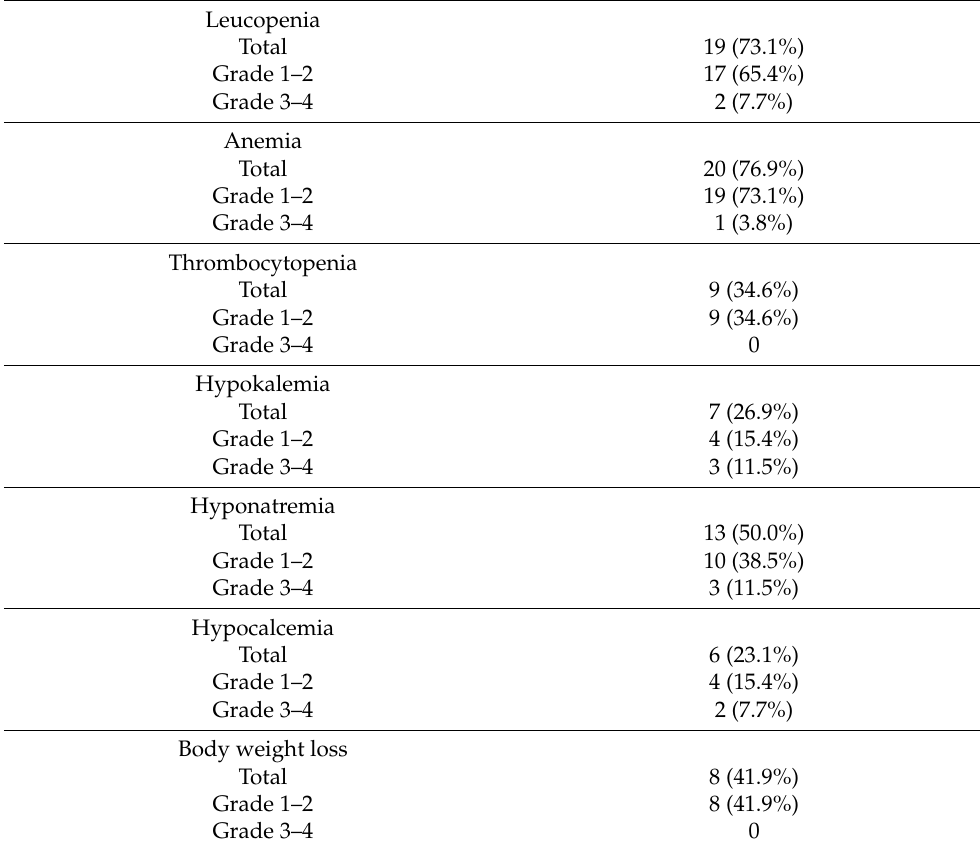
Table 2. Acute toxicities during adjuvant